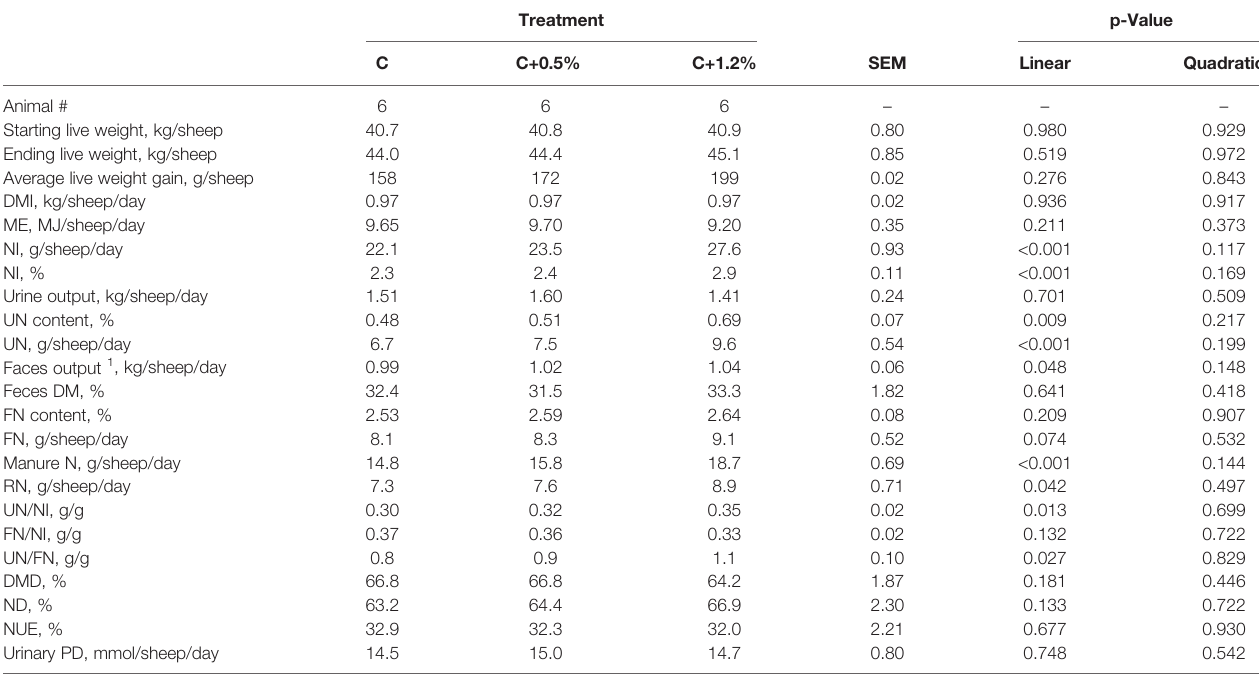
TABLE 2 | Nitrogen (N) partitioning in sheep offered three different levels of non-protein N. Treatment p-Value C C+0.5% C+1.2% SEM Linear